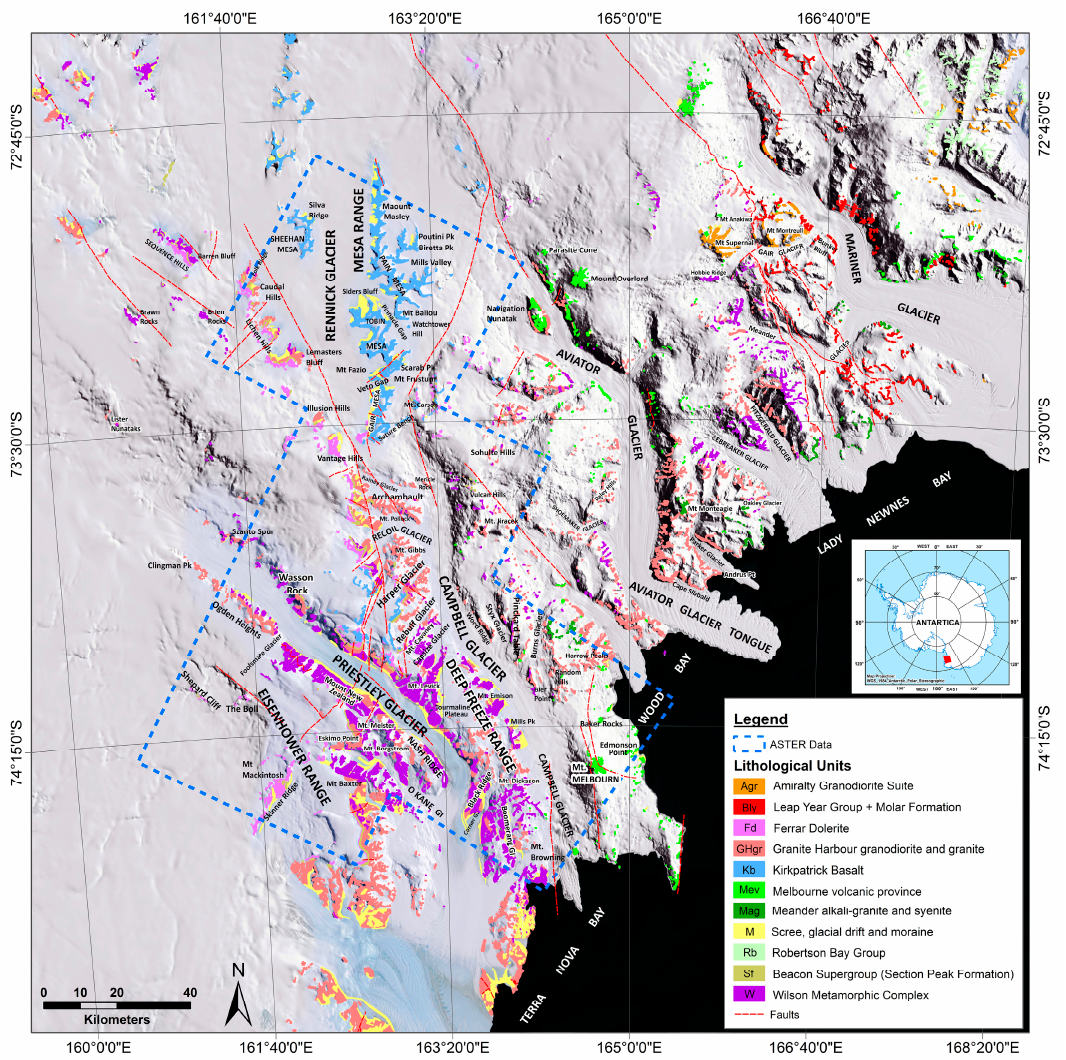
FIG 1 Figure 1. Geological map of the Mesa Range, Campbell and Priestley Glaciers and surrounding areas. Modified based on the GIGAMAP series and © SCAR GeoMAP 2019, adopted from Storti et al. [71] and Pertusati et al.